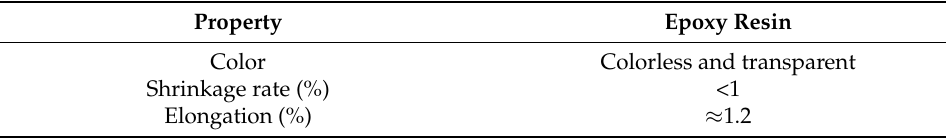
Table 2. Physical properties of the epoxy resin.